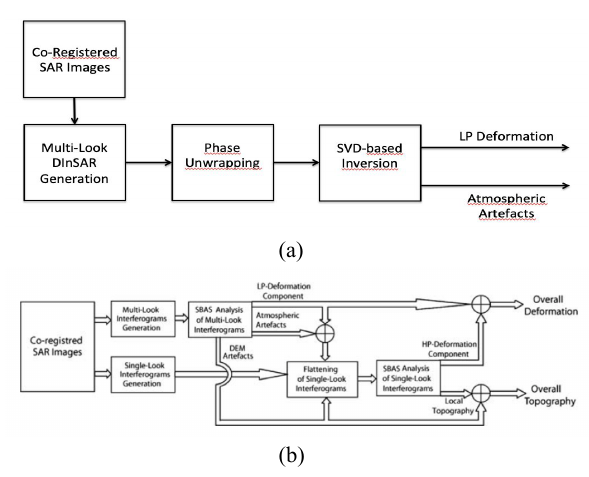
Figure 1. Processing chain of the SBAS algorithm at low- (a) and full- (b) spatial resolution scale, partly reproduced from Guzzetti et al. (2009) SBAS algorithm is applied to the sequences of archived SAR images collected by the ERS and ENVISAT satellites of the European Space Agency (ESA) from 1992 to 2010. A maximum perpendicular baseline of 400 m and a maximum time span of two years have been used for the selection of the SB interferometric data pairs for the selected AOIs of Naples, Milan, and Turin in Italy. SBAS-DInSAR deformation data products are produced at a medium spatial scale and for some spotted areas in the residential and center areas of the selected AOIs also at the scale of every single